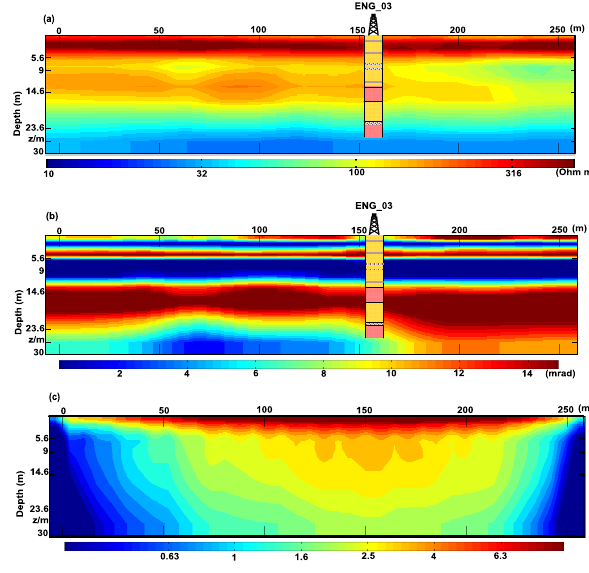
Fig. 4. The 2D IP inversion results of P2 profile (for location see Fig. 1). (a) The resistivity 79 amplitude (|ρ|), (b) conductivity phase shift ( ) and (c) coverage section (0.625 Hz data). 80 Fig. 4. Same as Fig. 3 but for profile